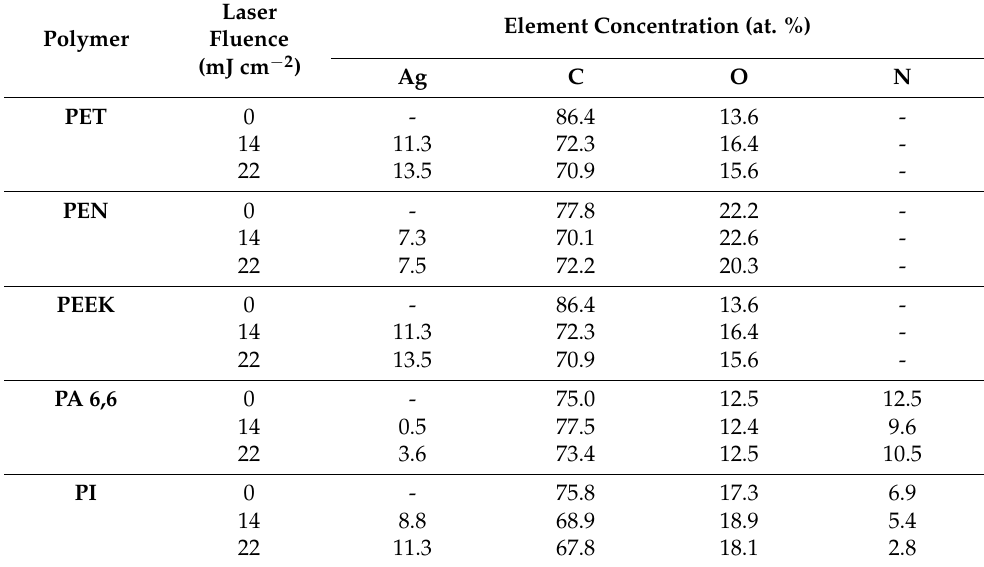
Table 1. Concentrations of silver Ag3d, carbon C1s, oxygen O1s, and nitrogen N1s (in at. %) in pristine and AgNP-immobilized polymers, derived from XPS